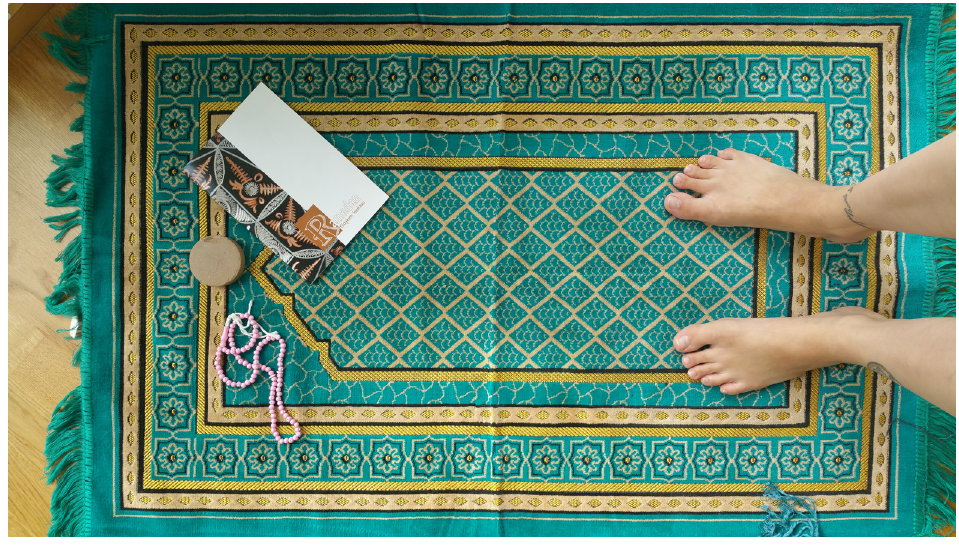
Figure 2. My prayer